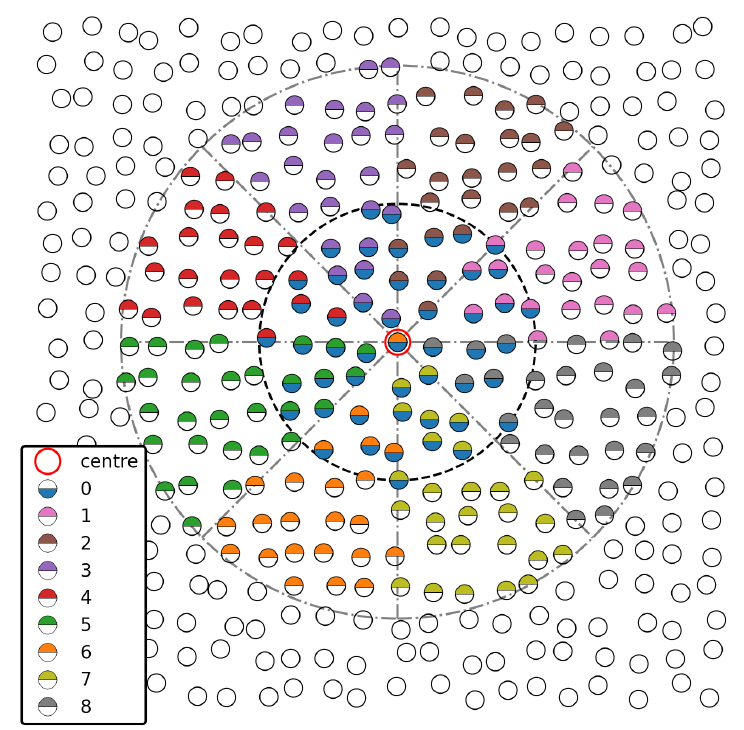
Figure 1. Sketch of the central and the one-sided lateral stencils for a sample randomized 2D particle